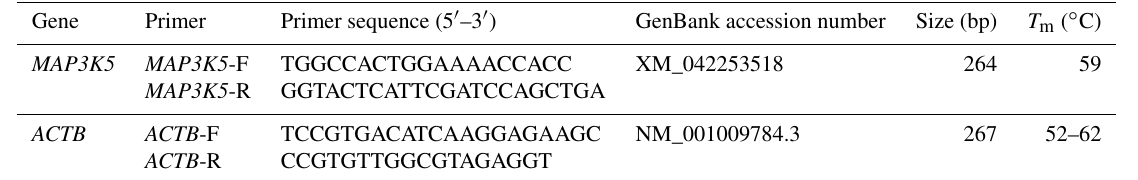
Table 5. Primers used for qRT-PCR for the ovine MAP3K5 gene.